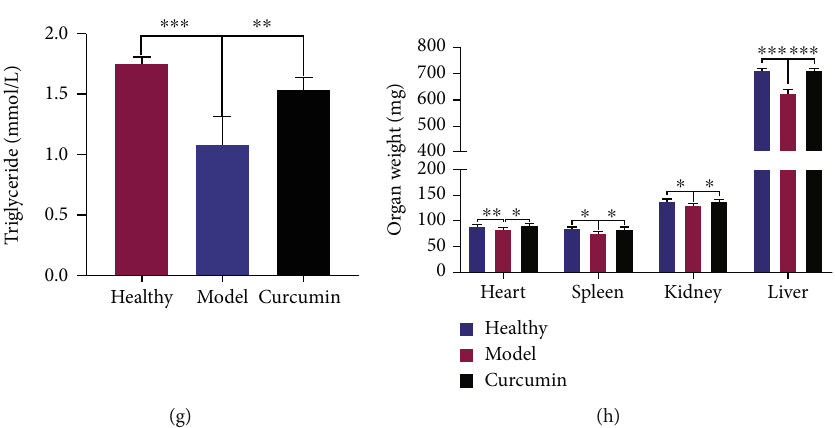
Figure 3: Curcumin alleviates the weight and organ loss and improved malnutrition in tumor-bearing mice. (a) Body weight change curves of the three groups during the 4-week intervention period. (b) Statistical analysis of the terminal body weight of three groups of mice. (c) Statistical analysis of the food intake of the 3 groups of mice during the 4-week observation period. (d – g) Statistical analysis of serum total protein, albumin, cholesterol, and triglyceride of mice in the healthy group, the model group, and the curcumin group at the end of the experiment. (h) Statistical analysis of the weight of the main organs of the three groups of mice at the end of the experiment. n = 8 /group. NS: not signi fi cant; ∗ p < 0 : 05 , ∗∗ p < 0 : 01 , ∗∗∗ p < 0 : 001 , and ∗∗∗∗ p < 0 : 0001 by t -test, compared to the model group. Data was shown as mean ± standard errorsof the mean